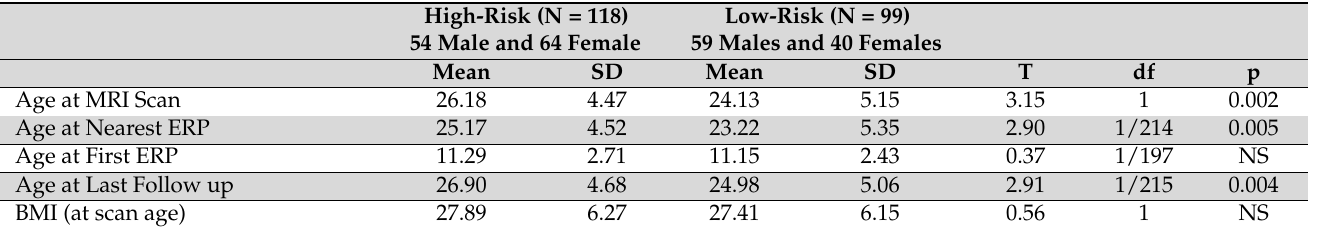
Table 1. Demographic Characteristics of High-Risk and Low-Risk Adolescents and Young Adults (N =